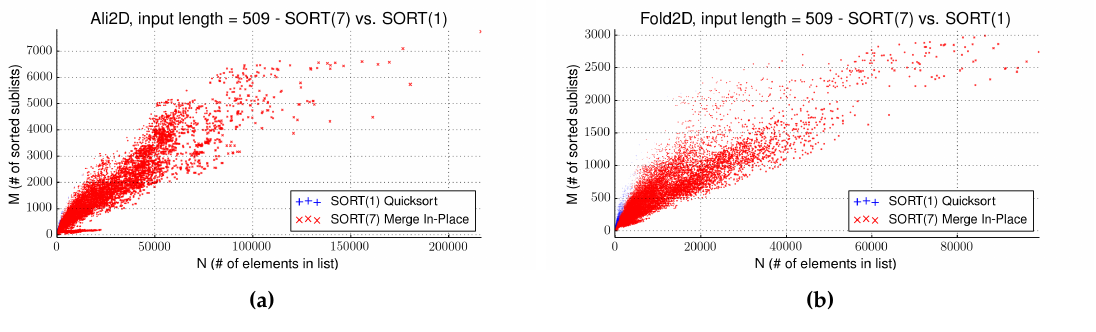
Figure 6. Runtime gain of individual data points of SORT(7) against SORT(1) for ( a ) Ali2D and ( b ) Fold2D. Points are plotted when one algorithm performed better than the other with point sizes relative to the gained time. The point of interest here is not performance, but the observation that both problems produce intermediate results of significantly different